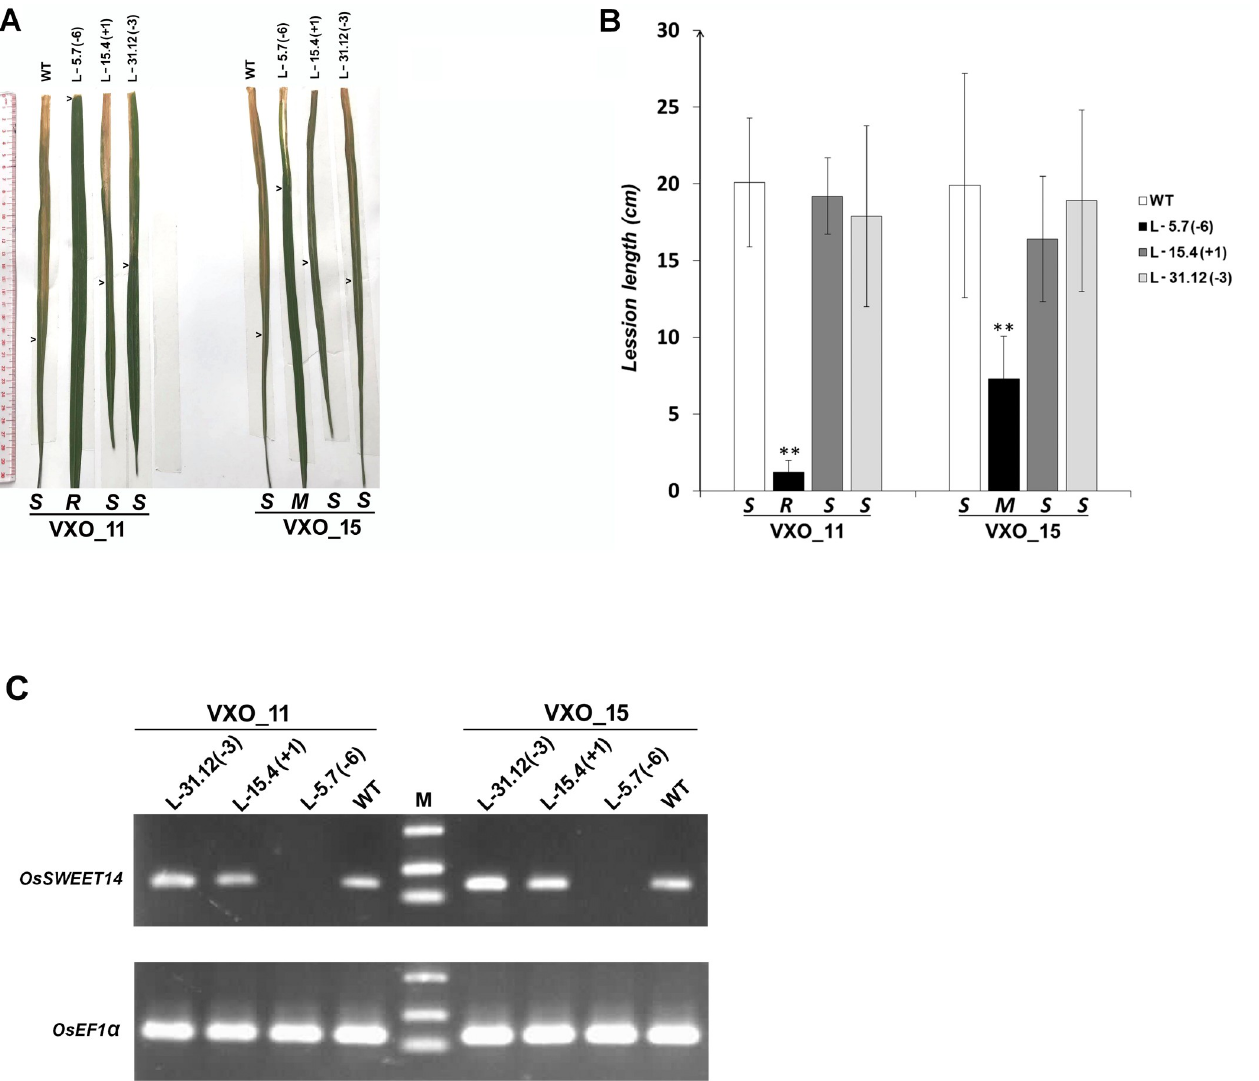
Fig 3. BLB resistance assays for homozygous mutant rice lines L-5.7(-6), L-15.4(+1) and L-31.12(-3). (A) Leaves were photographed 14 days post-leaf clipping inoculation of Xoo strains VXO_11 and VXO_15; arrow heads indicate the end of the lesion. (B) Mean lesion lengths (bars) and standard deviations (error bars). Values were measured 14 days post-leaf clipping inoculation of two Xoo strains VXO_11 and VXO_15 and were computed from at least three leaves from each of three plants. Asterisks indicate significant differences relative to wild type plants (Tukey’s HSD test; �� P < 0.05). The number in the parentheses following the line name indicates the type of mutation and the number of nucleotides involved. The letters above strain labels indicate susceptibility score (R—high resistance; M–moderate resistance; S—susceptibility). The experiment was repeated three times. (C) OsSWEET14 expression pattern obtained by RT-PCR two day post-infiltration of genome edited homozygous mutant rice lines L-31.12(-3), L-15.4(+1) and L-5.7(-6) and parental TBR225 rice leaves with Vietnamese Xoo strains. This experiment was repeated two times with similar results.